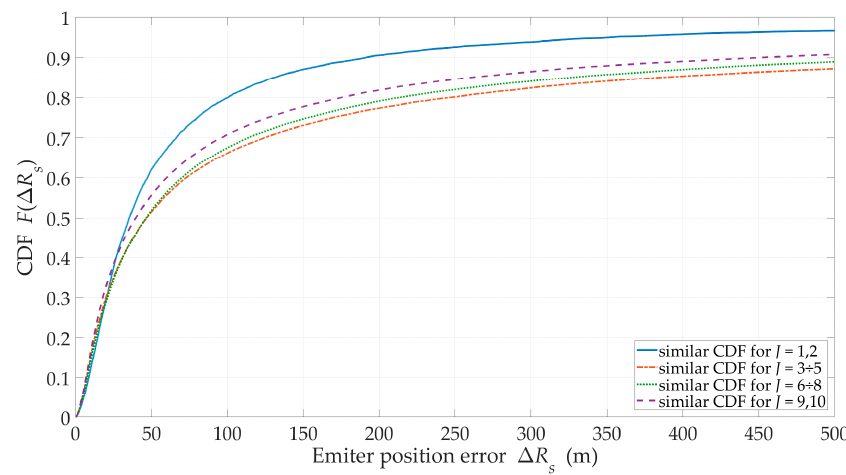
Figure 8. CDFs of location error versus number of sensors in swarm for suburban area.